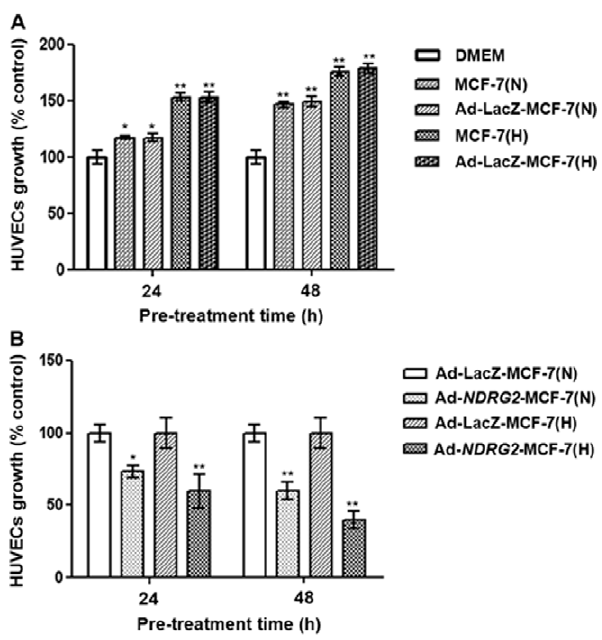
Figure 2. Effect of MCF-7 preconditioned media on HUVEC proliferation. (A) HUVECs were grown to confluence and were then cultured in preconditioned media (derived from MCF-7 and Ad-LacZ- MCF-7 cells pretreated under normoxia and hypoxia for 24 or 48 h) for 24 h, and serum-free DMEM was used as a control. (B) HUVECs were grown to confluence and were then cultured in preconditioned media (derived from Ad-LacZ-MCF-7 or Ad- NDRG2 -MCF-7 cells pretreated under normoxia and hypoxia for 24 or 48 h) for 24 h. Ad-LacZ -MCF- 7(N) or Ad-LacZ-MCF-7 (H) was used as controls. N, normoxia; H, hypoxia. The data are the mean 6 standard deviation (SD) for three independent experiments. Statistical significance was assessed using one-way ANOVA and Student’s t -test. * or ** indicates P , 0.05 or P , 0.01, respectively, when compared with the control.